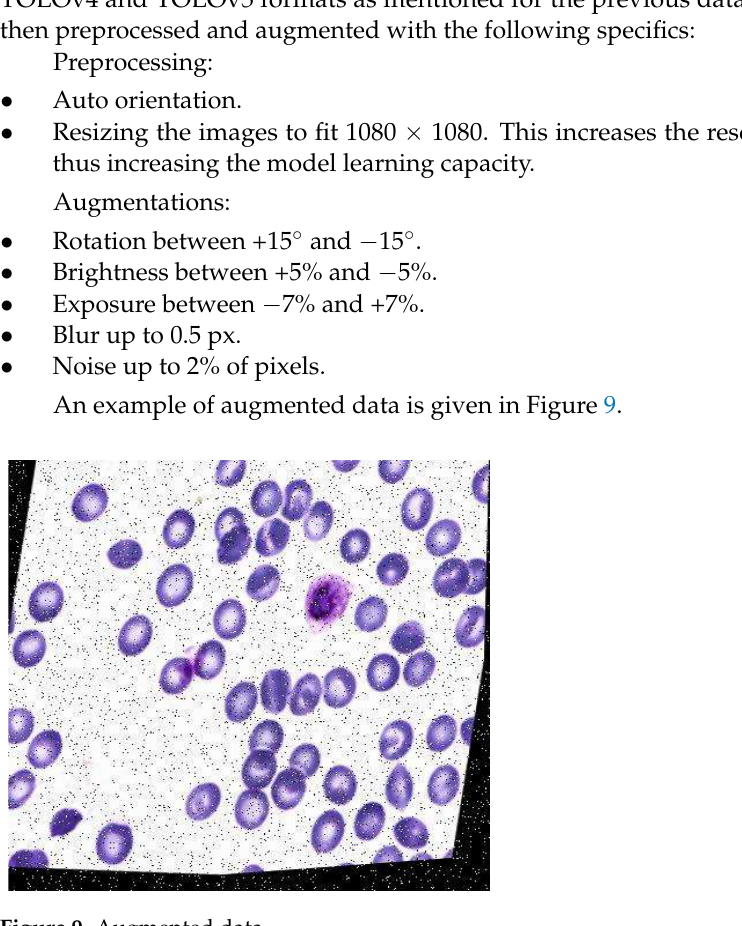
Table 3. Comparison between scaled YOLOv4 and